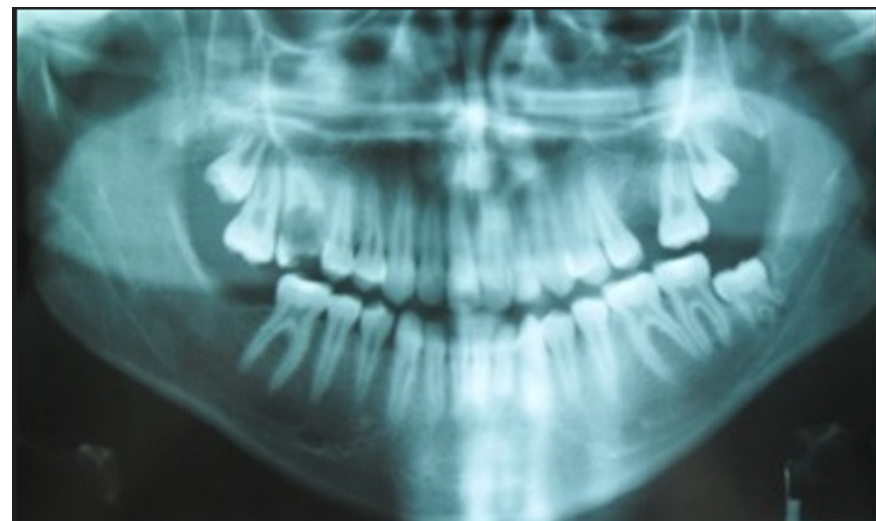
Figure 8. Control panoramic radiograph and completely healed bone after treatment.